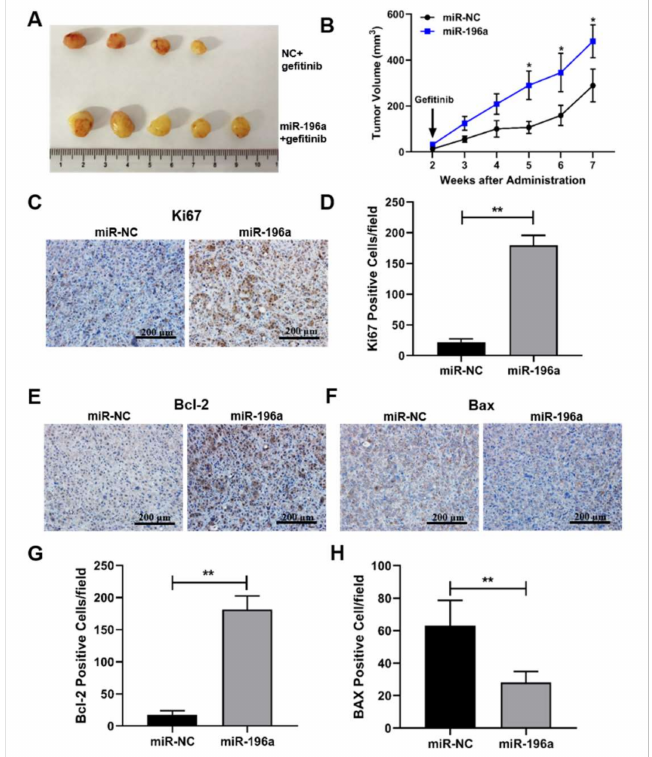
Figure 7. miR-196a-forced expression promoted tumor growth and inhibited cell apoptosis by treatment gefitinib in vivo . PC-9 cells (3 million) overexpressing NC control or miR-196a were subcutaneously injected into nude mice. When the tumor volume reached 50 mm 3 , gefitinib was given by gavage every two days. ( A ) The miR-NC and miR-196a overexpression group tumors were stripped out at the end of treatment and tumor images were shown. ( B ) The tumor volumes were measured every week, and tumor growth curves were shown. ( C , D ) The representative images and quantitative signals of Ki67 staining were analyzed by IHC in tumor sections. ( E – H ) The representative images and quantitative results were analyzed in BCL-2 and BAX by IHC staining in tumor sections. Data represent the mean ± S.D. of 3 independent experiments where ** indicates significant difference at p < 0.01 * indicates at p <